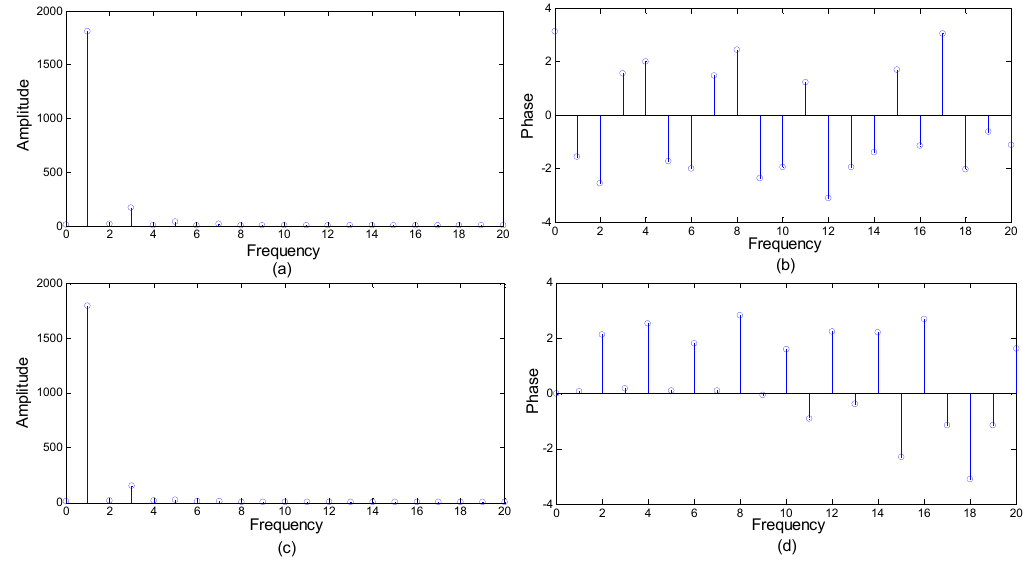
Figure 6. Amplitude-frequency characteristics of Moiré fringe signals: ( a ) the amplitude characteristics of the SIN signal; ( b ) the phase characteristics of the SIN signal; ( c ) the amplitude characteristics of the COS signal; ( d ) the phase characteristics of the COS signal.